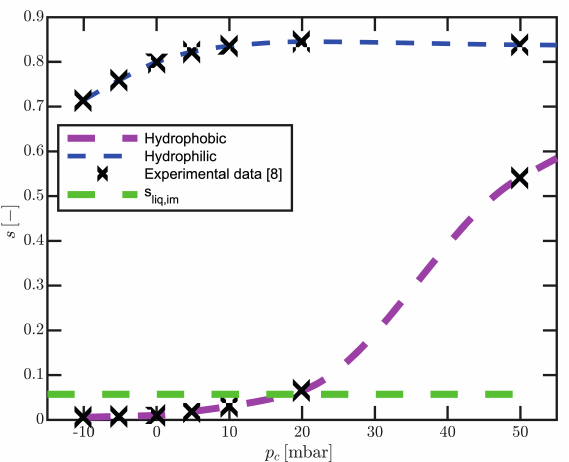
Figure A1. Capillary pressure-saturation curve: piecewise cubic fit to experimental data presented